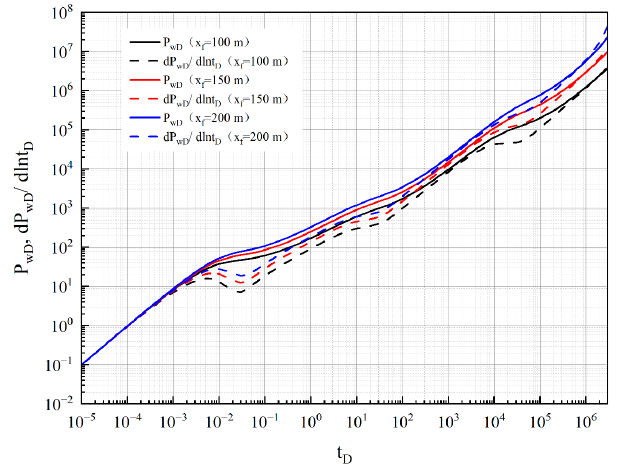
Figure 10. The effect of the FSRV half-length on the pressure response.